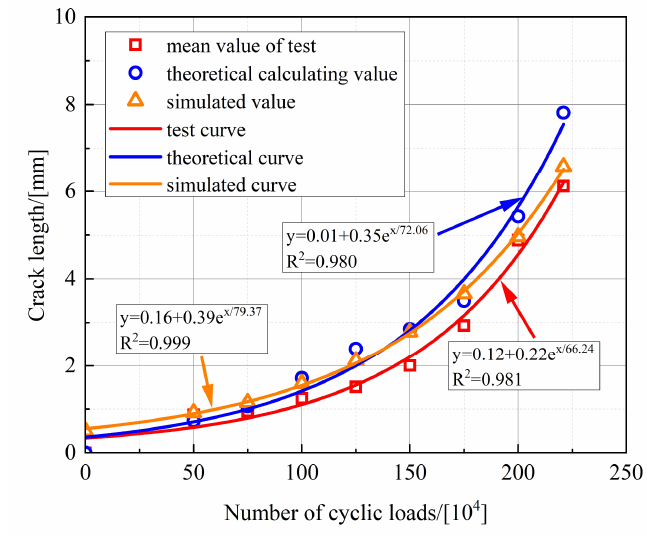
Figure 25. Comparison of simulated, theoretical, and test curves.